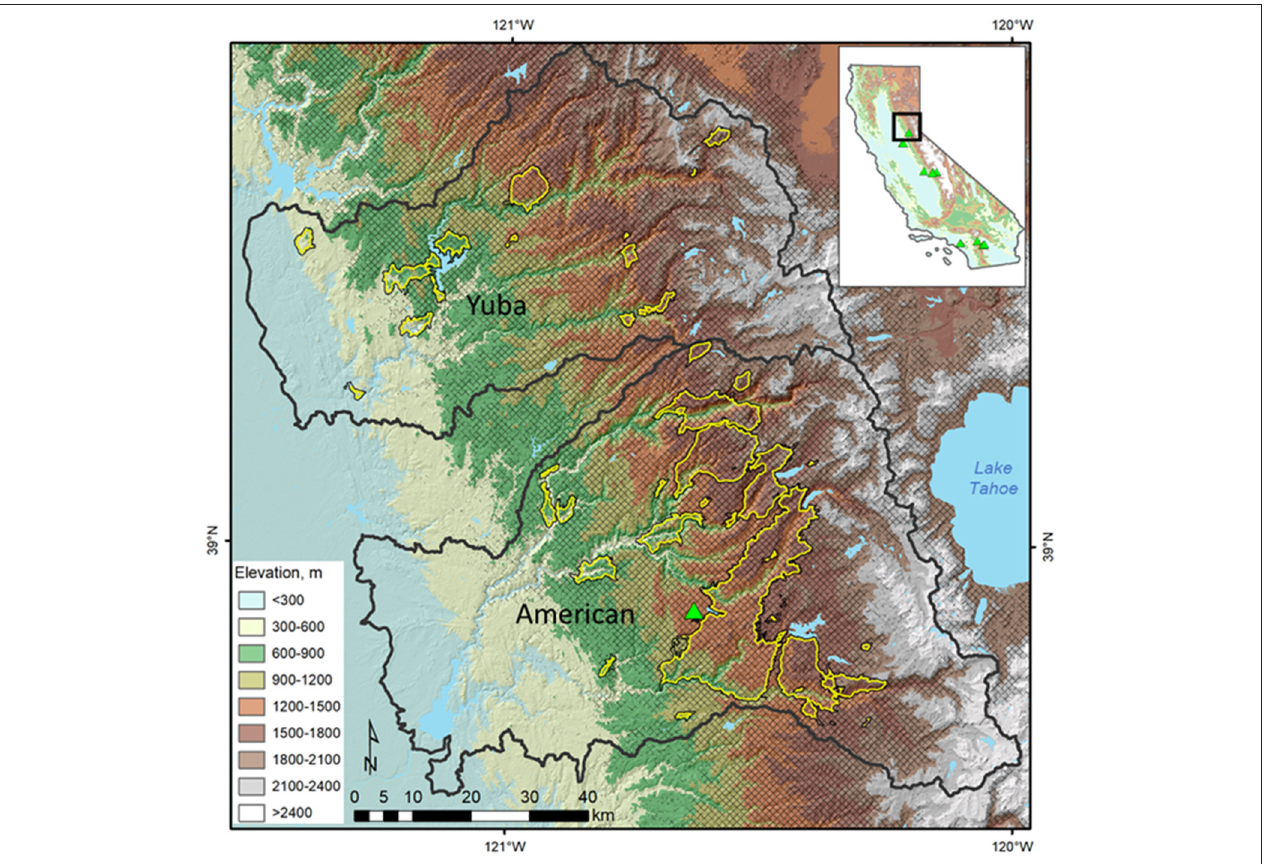
FIGURE 1 | Study area shaded by 300-m elevation bands. Fire perimeters (yellow–black outlines) are all fires to occur in the Yuba and American watersheds > 50 ha (1985–2017). Cross-hatching indicates the extent of mixed conifer forest. Inset depicts the study location within the state of California, USA. Green triangles on insert and main map show locations of flux towers used in this